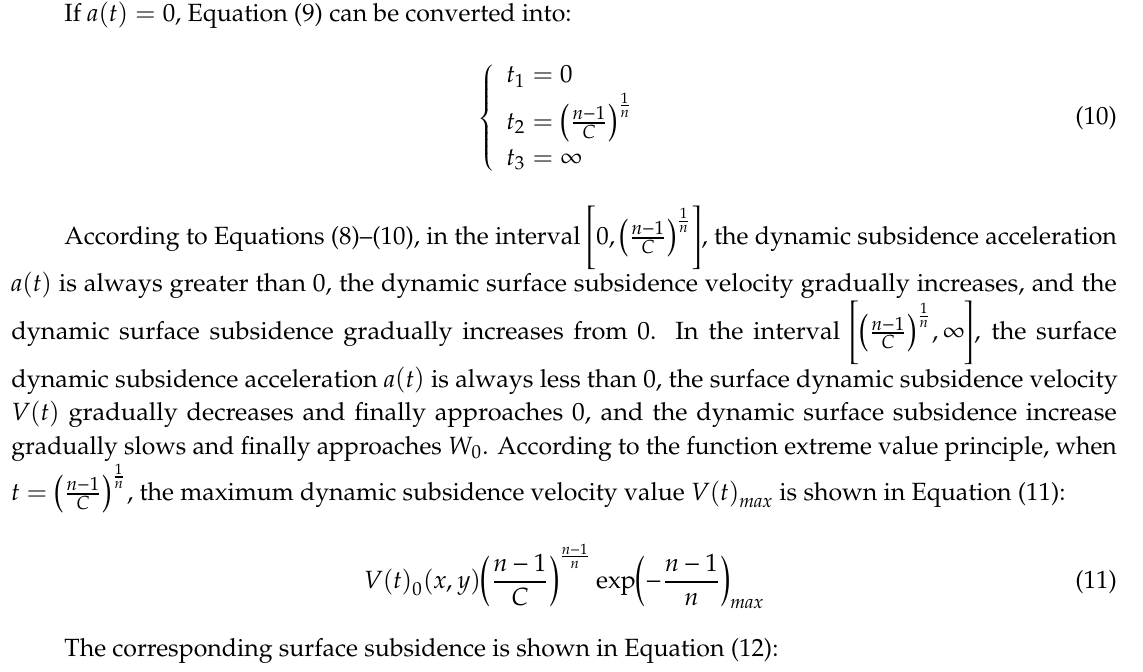
Figure 3. The influence of model order n on surface subsidence velocity.